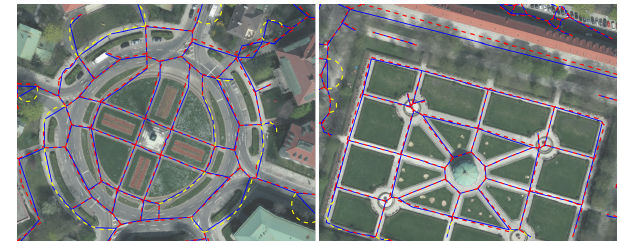
Figure 6: Detailed views of generalization results using polyline- wise (not chain-wise) alternative methods. Blue lines: Modified Douglas and Peucker (1973) algorithm, yellow and red dashed lines: Model selection approach from Sec.